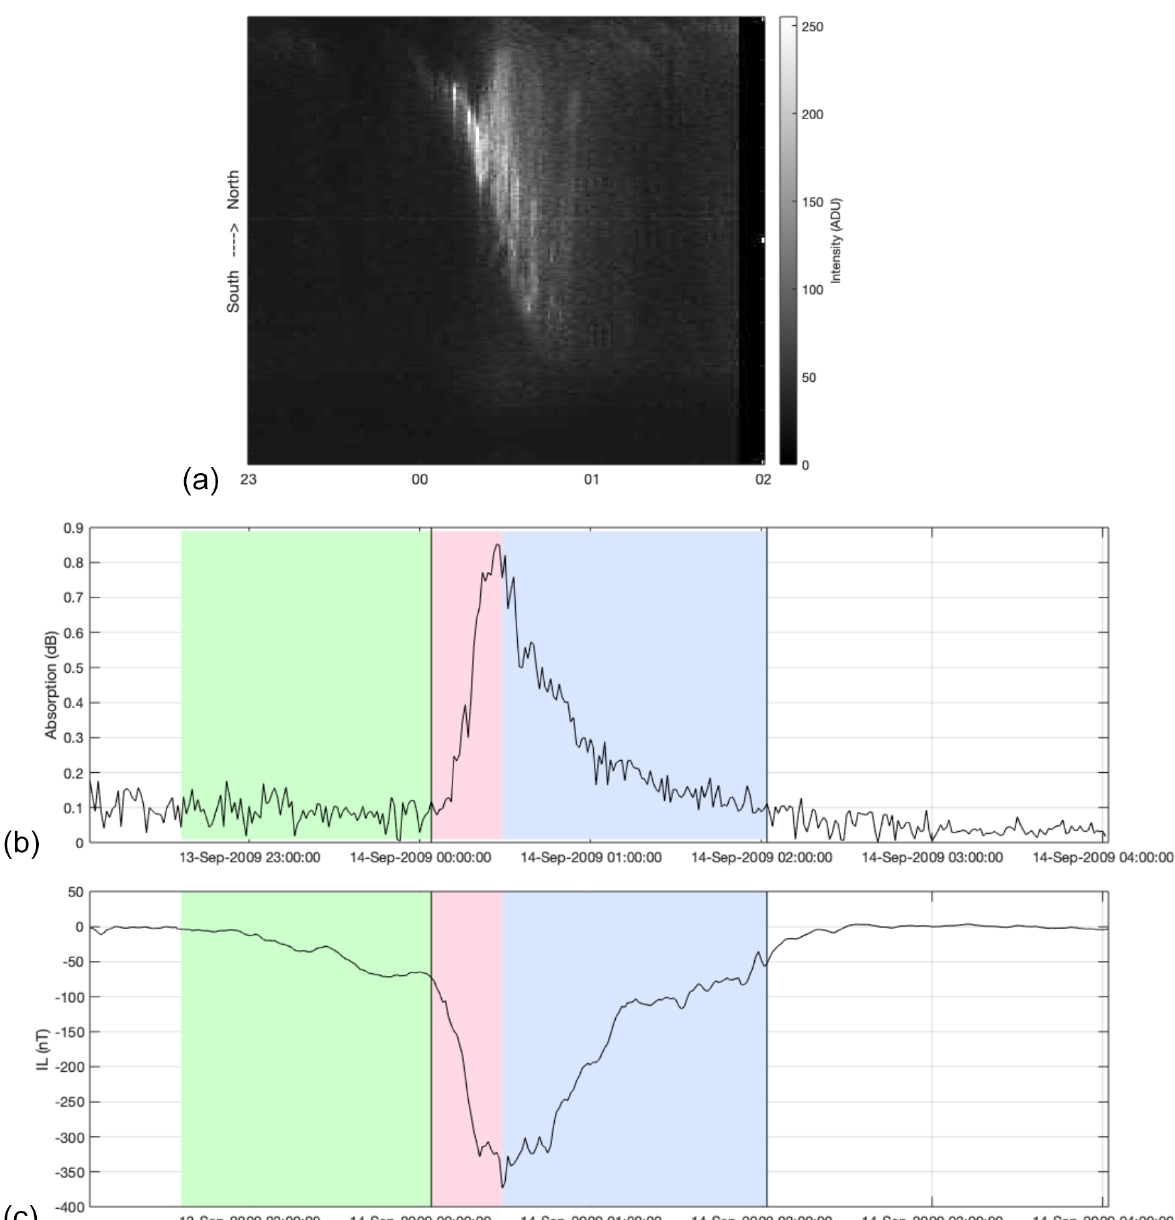
Figure 1. An example of an isolated substorm event with a single expansion (red) and recovery (blue). The vertical lines mark the time period which is used in the analysis, i.e. from the expansion onset until the end of the recovery phase. The green shaded area marks the growth phase as determined by the search algorithm. Displayed is the temporal evolution of CNA (b) and the IL index (c) . Panel (a) shows the auroral evolution at 557.7nm as a keogram (north–south slice as a function of time) from the SOD camera station aligned to match the timing of data in b and c